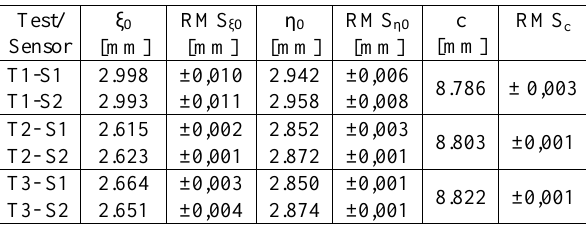
Table 2. Main statistical parameters related to Principal Point